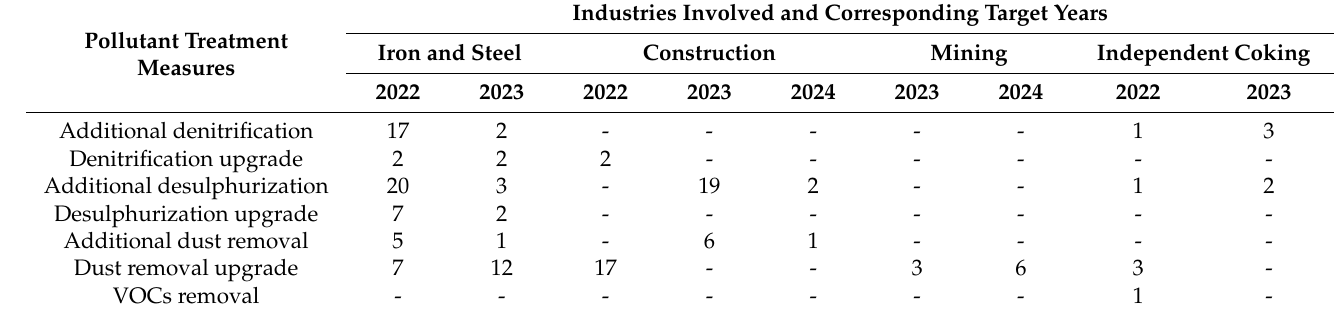
Table 2. Statistics on the number of key industrial pollutant treatment facilities